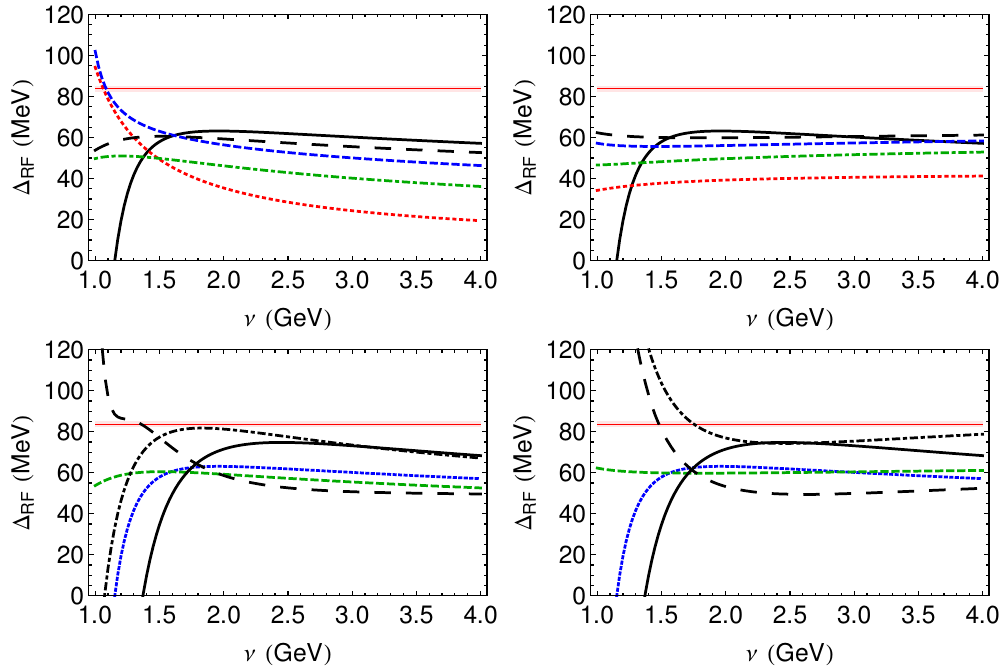
Figure 10 . Plot of (cid:1) RF = M B (cid:0) M (cid:17) = 2 (cid:0) M (cid:17) = 2 in MeV in the RS’ scheme for (cid:23) f = 1 GeV, c c b m b; RS 0 = 4 : 885 GeV, m c; RS 0 = 1 : 496 GeV. Red band is the experimental value. Upper left panel: (cid:23) r = 1 GeV. Red dotted, green dot-dashed, blue dashed and black long-dashed are the results obtained solving eq. (4.1) with the static potential truncated at N=0,1,2,3, respectively. Solid black line is the N = 3 previous result in strict (cid:12)xed-order perturbation theory. Upper right panel: as in the upper left panel but with (cid:23) r = 1 GeV. Lower left panel: (cid:23) r = 1 GeV. Blue dotted line corresponds to the solid black line of the above (cid:12)gure, green short-dashed line corresponds to the long-dashed black line of the above (cid:12)gure. The other lines incorporate the relativistic and ultrasoft corrections. Solid black line is the full result in strict (cid:12)xed-order perturbation theory (solid black line in (cid:12)gure 5). The long-dashed black line corresponds to eq. (4.7) evaluating the relativistic corrections with the wave function obtained from the N = 3 static potential. The dot-dashed black line corresponds to eq. (4.7) evaluating the O ( mv 4 ) relativistic corrections with the wave function obtained from the N = 1 static potential and the O ( mv 4 (cid:11) s ) relativistic corrections with the wave function obtained from the N = 0 static potential. Lower right panel: as in the lower left panel but with (cid:23) r = 1